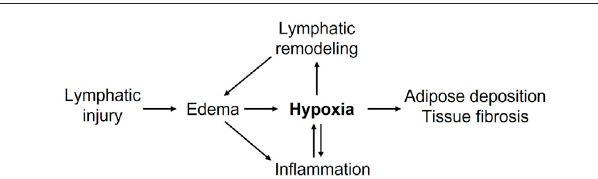
FIGURE 1 | Putative roles of hypoxia in promoting lymphedema pathogenesis. Lymphatic injury-caused edema promotes in fl ammation and tissue hypoxia. Decreased tissue oxygenation further enhances in fl ammatory responses, lymphatic vascular remodeling, adipose deposition, tissue fi brosis, and collectively exacerbates